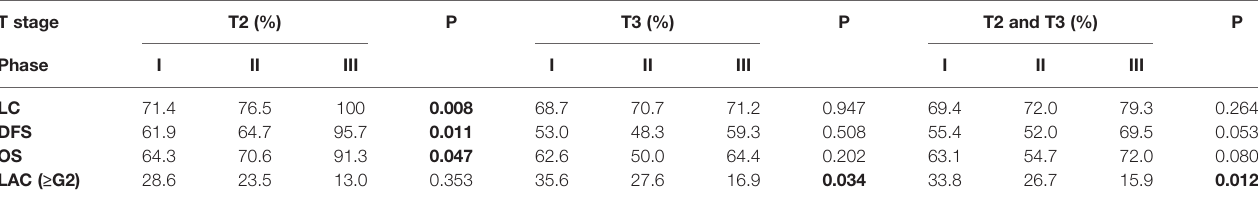
LC = Local contral rate, DFS = Disease-free survivl rate, OS = Overal survival rate. Bold means that the P value is less than 0.05.